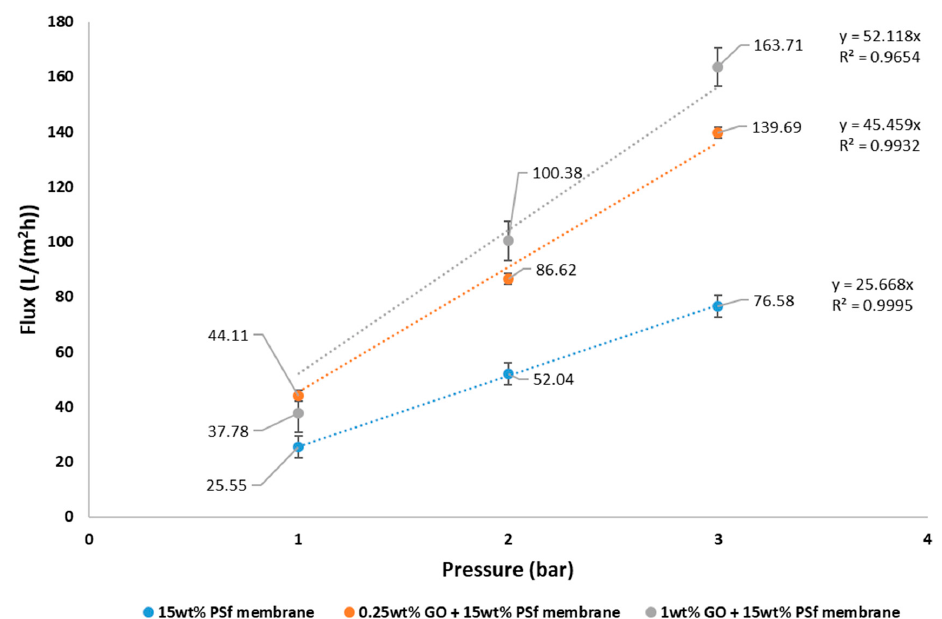
Figure 4. Pure water flux and permeability of prepared membranes.